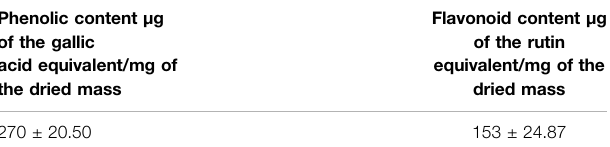
TABLE 1 | Total phenolic and fl avonoid contents of